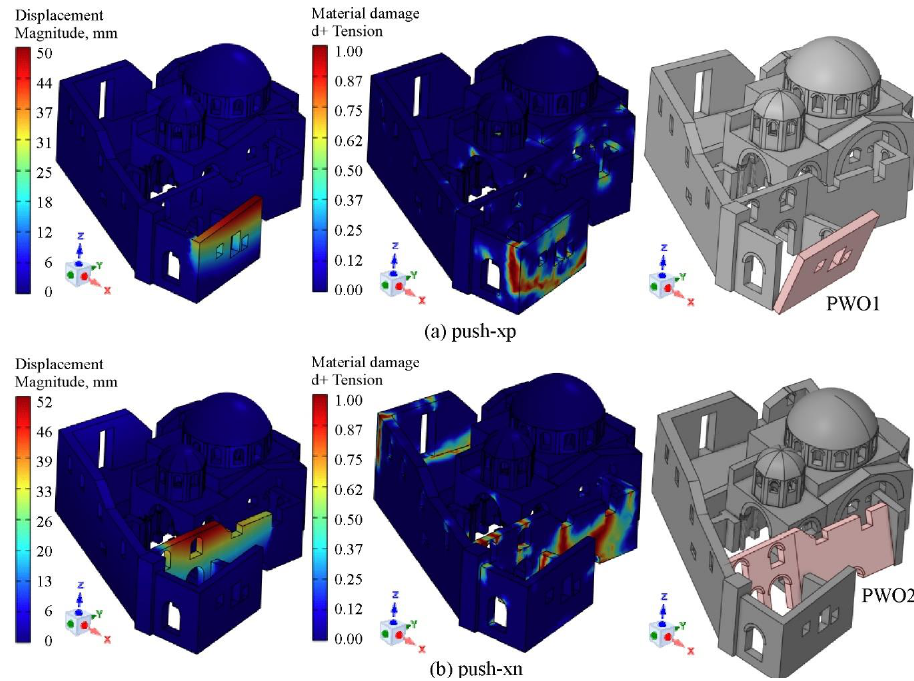
Figure 23. Displacements, damages and failure mechanisms of perimeter walls in push-x directions.